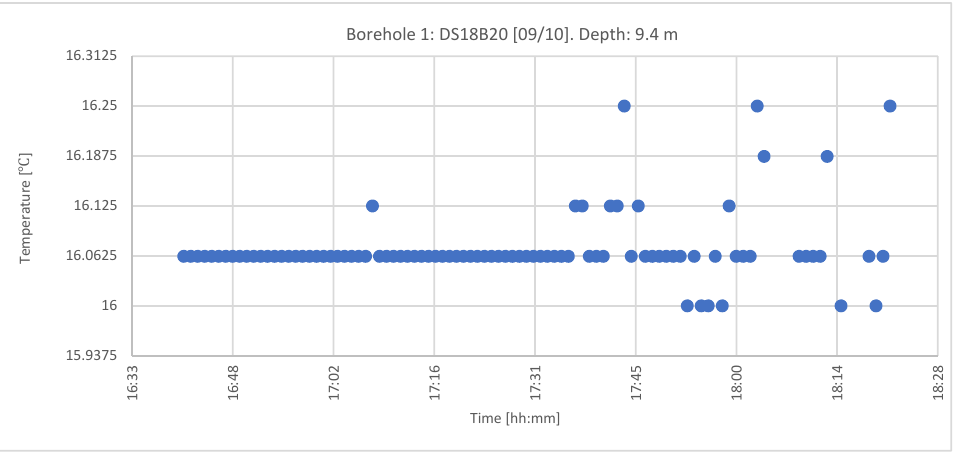
Figure 26. Temperature records from 9 October 2012 at the “Q-Thermie-Uniovi-1” borehole with DS18B20 sensors.